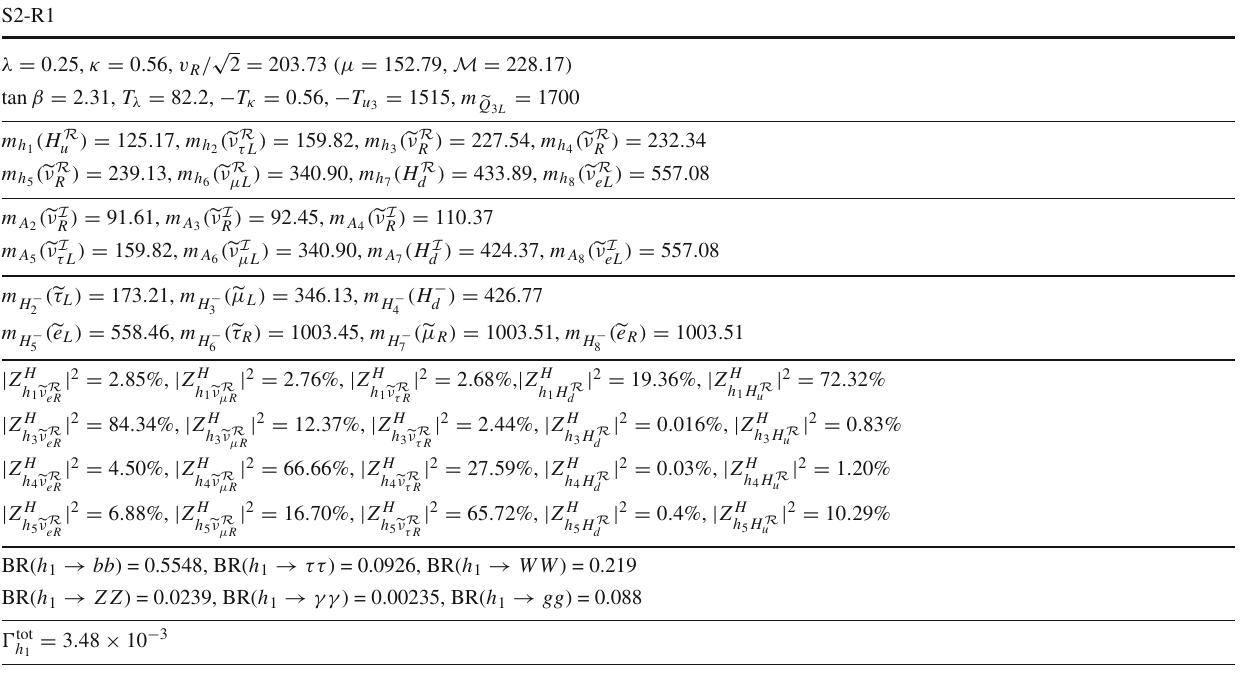
Table 8 The same as in Table 7, but for another benchmark point S2-R2 S2-R2 λ = 0 . 231, κ = 0 . 4, v